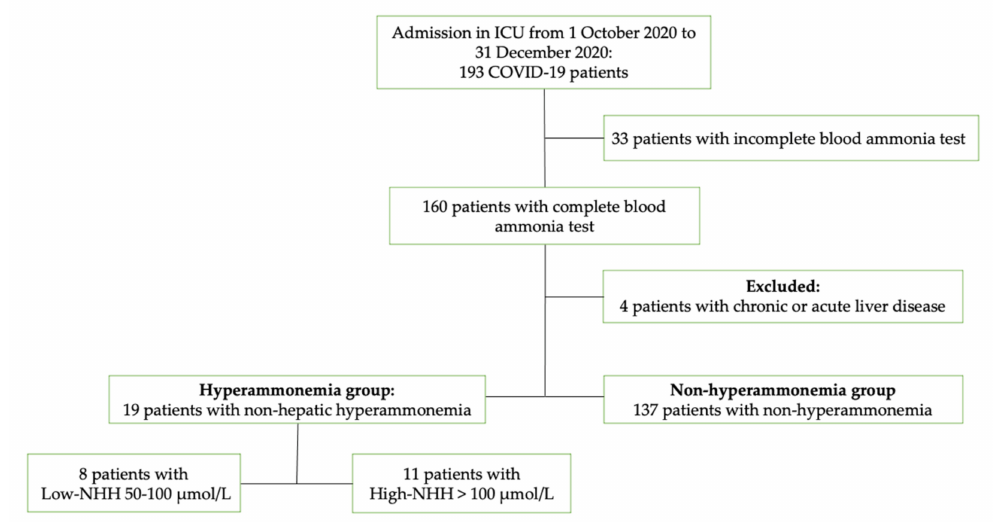
Figure 1. Flowchart of study selection; Abbreviations: COVID-19, Coronavirus disease 2019; ICU, intensive care unit; NHH, non-hepatic